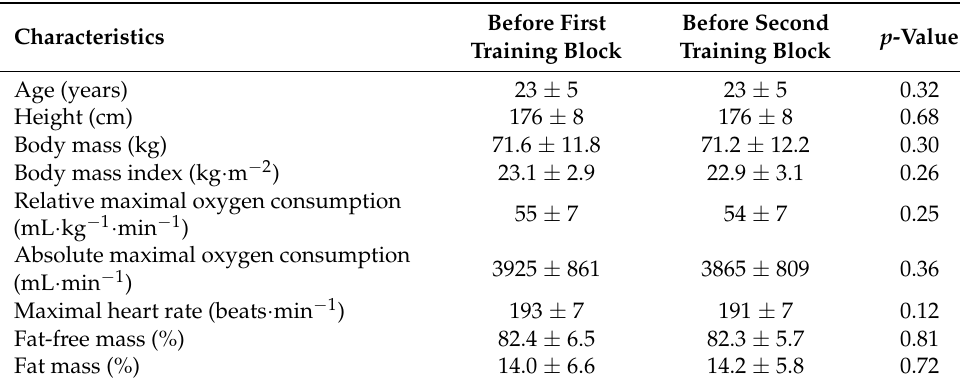
Table 1. Participants’ characteristics before starting each training